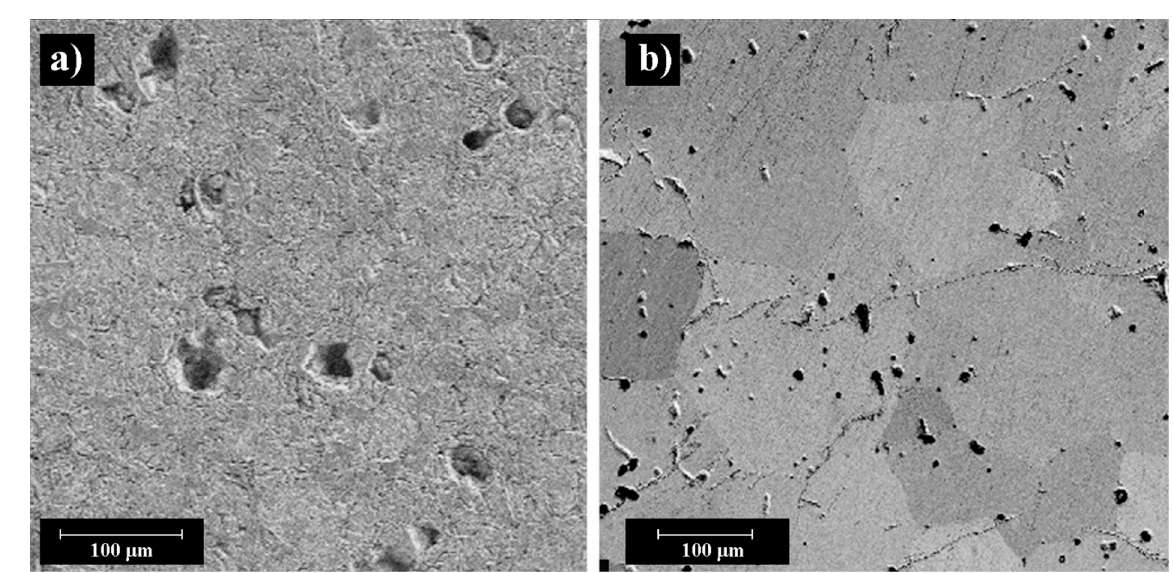
Figure 10. SEM images of sintered samples microstructures at 1400 °C, a dwell time of 6 h from C-BaTiO 3 ( a ) and F-BaTiO 3 ( b ) powders.